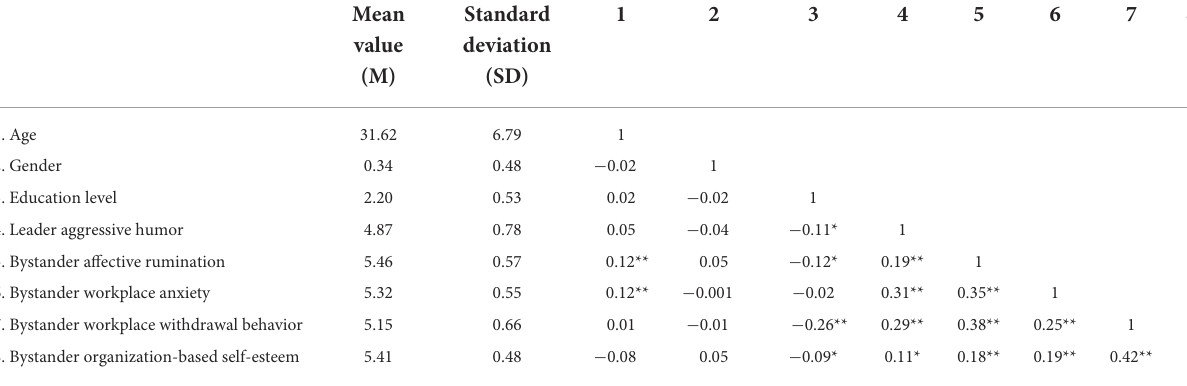
TABLE 2 Mean value, SD, and correlation coefficient of main variables.